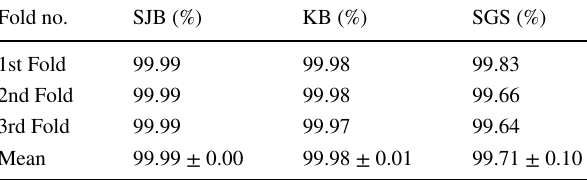
Table 1 Threefold cross-validation results at SJB, KB and SGS Fold no.